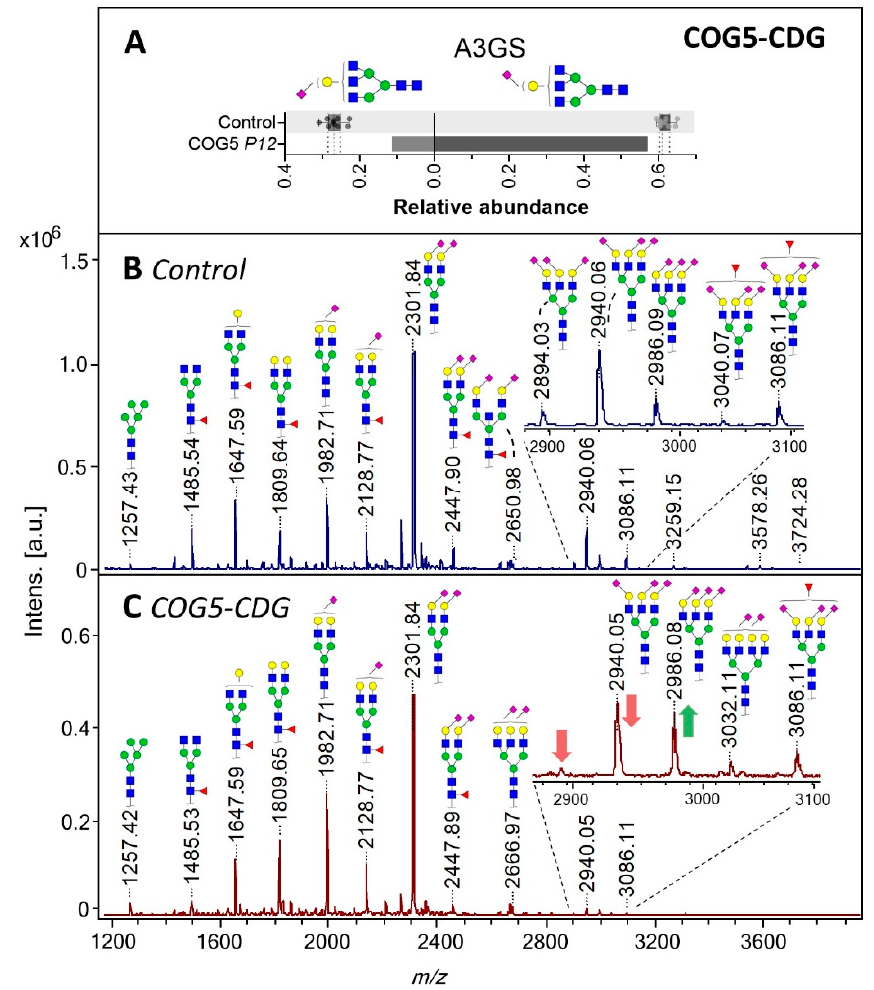
Figure 2. Total plasma N -glycome (TPNG) of a COG5-CDG patient. ( A ) Levels of α 2,3-sialylation per galactose (left) and α 2,6-linked sialylation per galactose (right) on triantennary glycans (A3GS) of TPNG. The box plot shows the median (dashed line) with the interquartile range (dotted lines) for healthy controls ( n = 10) whilst the bars give the values determined for the COG5-CDG patient. ( B ) and ( C ) show the TPNG MALDI-TOF-MS profiles of healthy control 5 and the COG5-CDG patient, respectively. All glycans were detected as [M + Na] + . For glycan annotation see Figure 1.